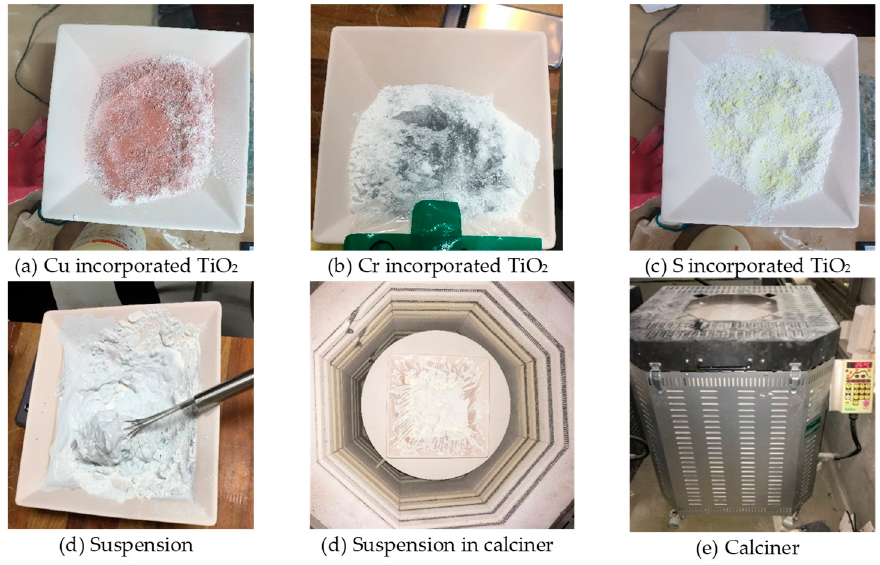
Figure 5. Detailed images of doping TiO 2.